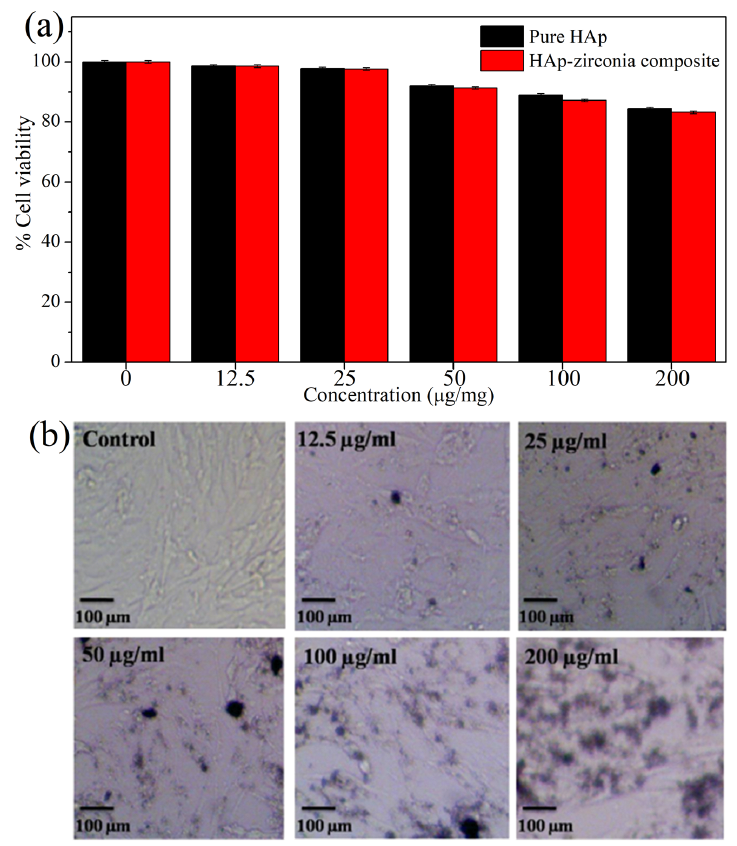
Figure 6. ( a ) MTT assay of pure HAp and the HAp-Zirconia (HZ1) composite, and ( b ) optical micrographs of the MG-63 cell line treated for 48 h with different concentrations of the HAp-Zirconia (HZ1)